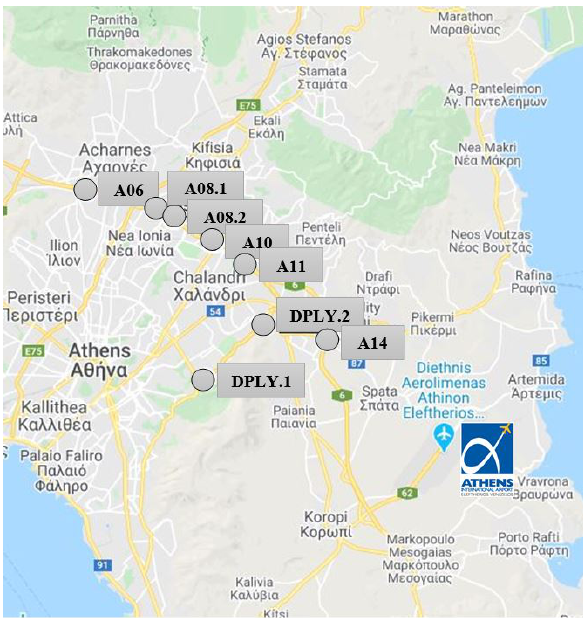
Figure 4: Locations of noise monitoring system of Attica Tollway